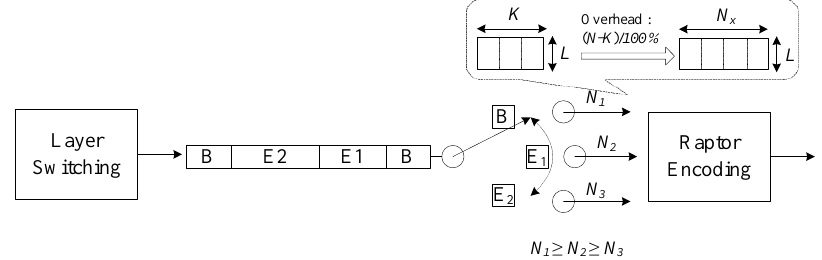
Figure 7. Layer importance-based unequal error protection (UEP) method.